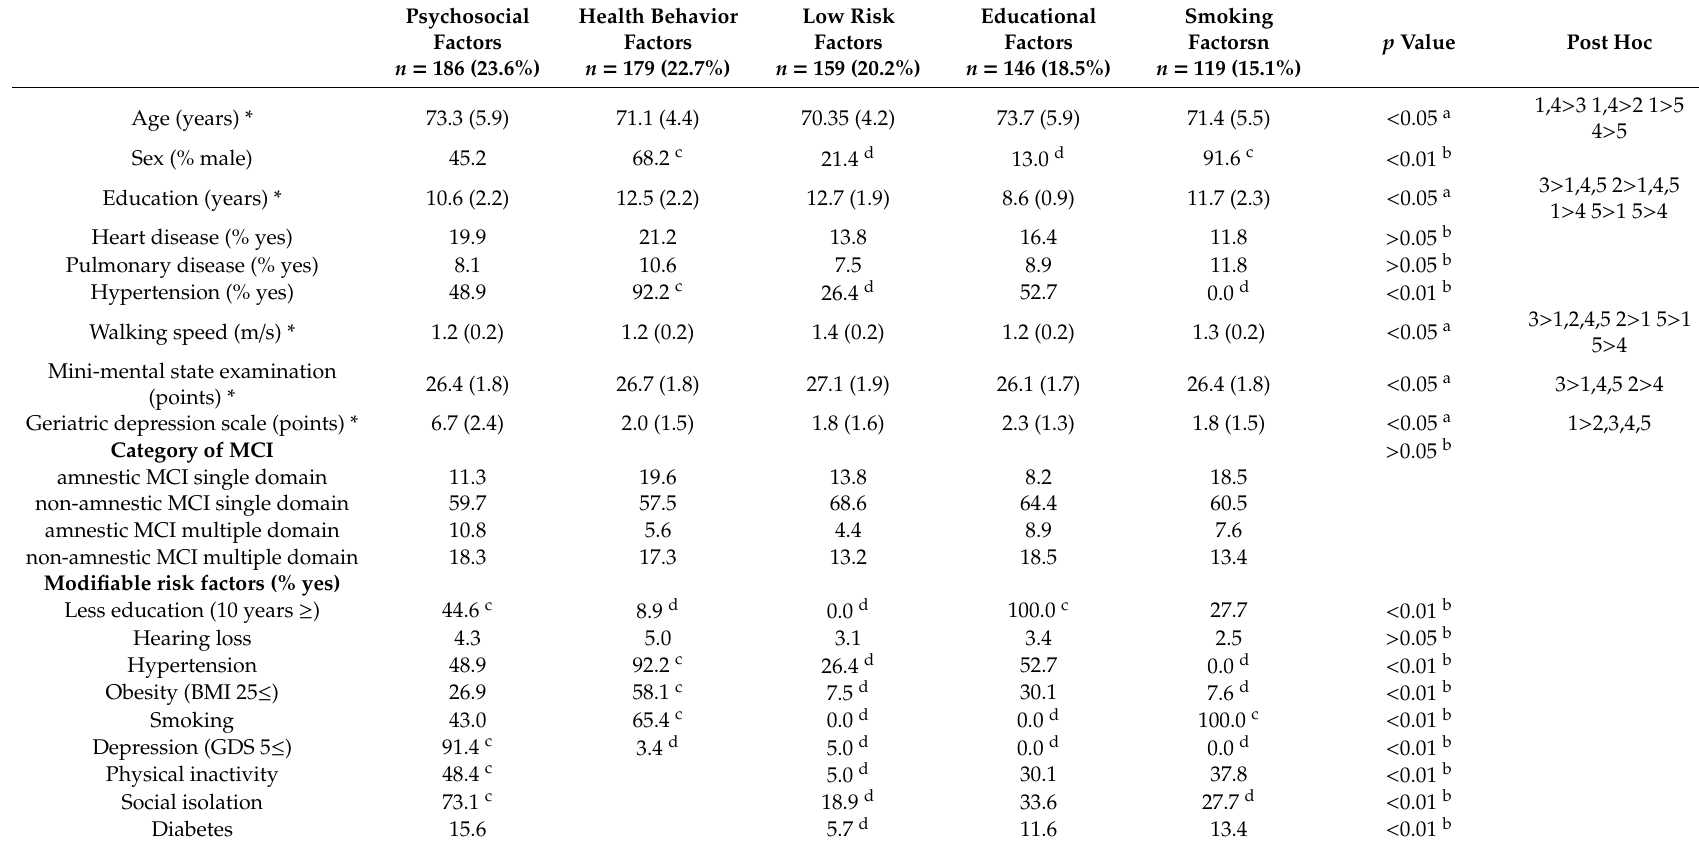
Table 4. Comparison of baseline characteristics of each